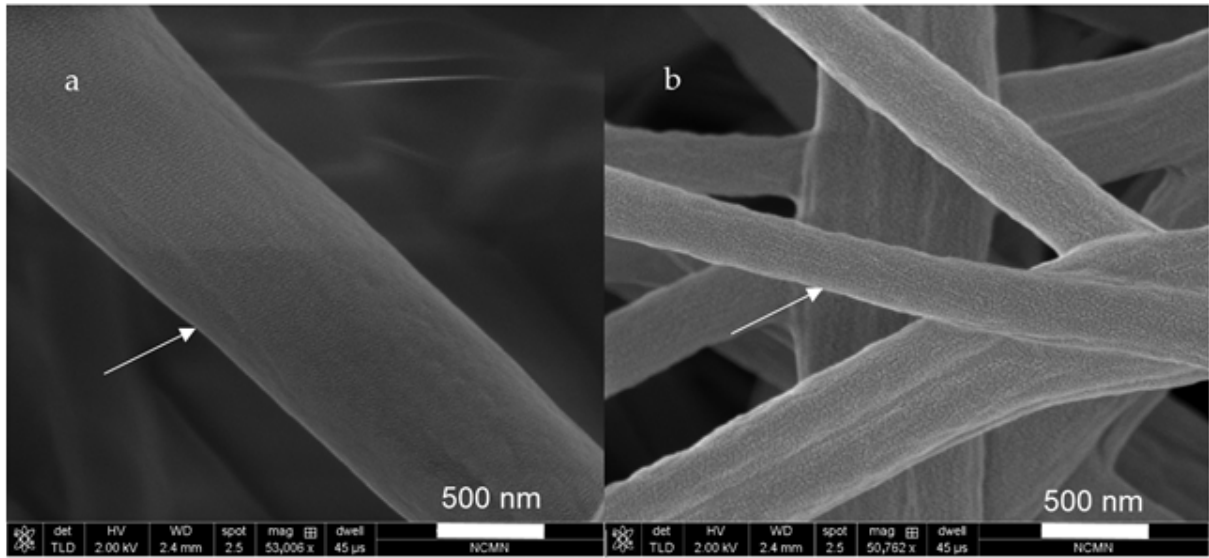
Figure 2. SEM images of PVC/PVP nanofibers and PAN/PEG nanofibers: ( a ) PVC with 16 wt/% PVP, ( b ) PAN with 32% PEG